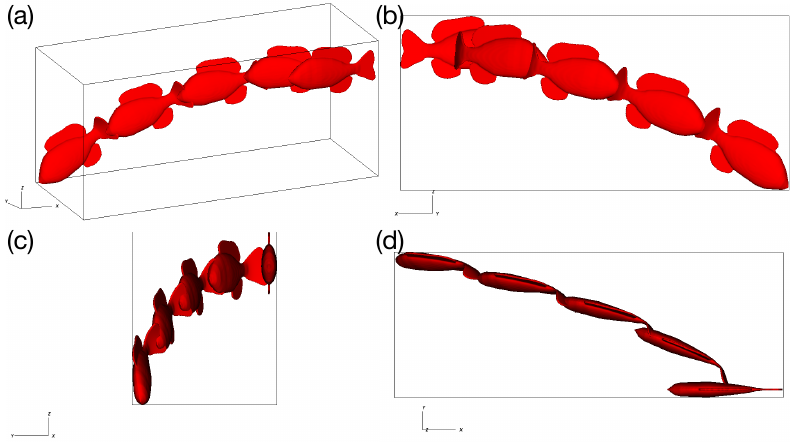
Figure 2. The trajectory over 10 actuation cycles of the unconstrained model using reference material parameters, with ( a ) an isometric view, ( b ) the view of the xz -plane, ( c ) the view of the yz -plane, and ( d ) the view from the xy plane.